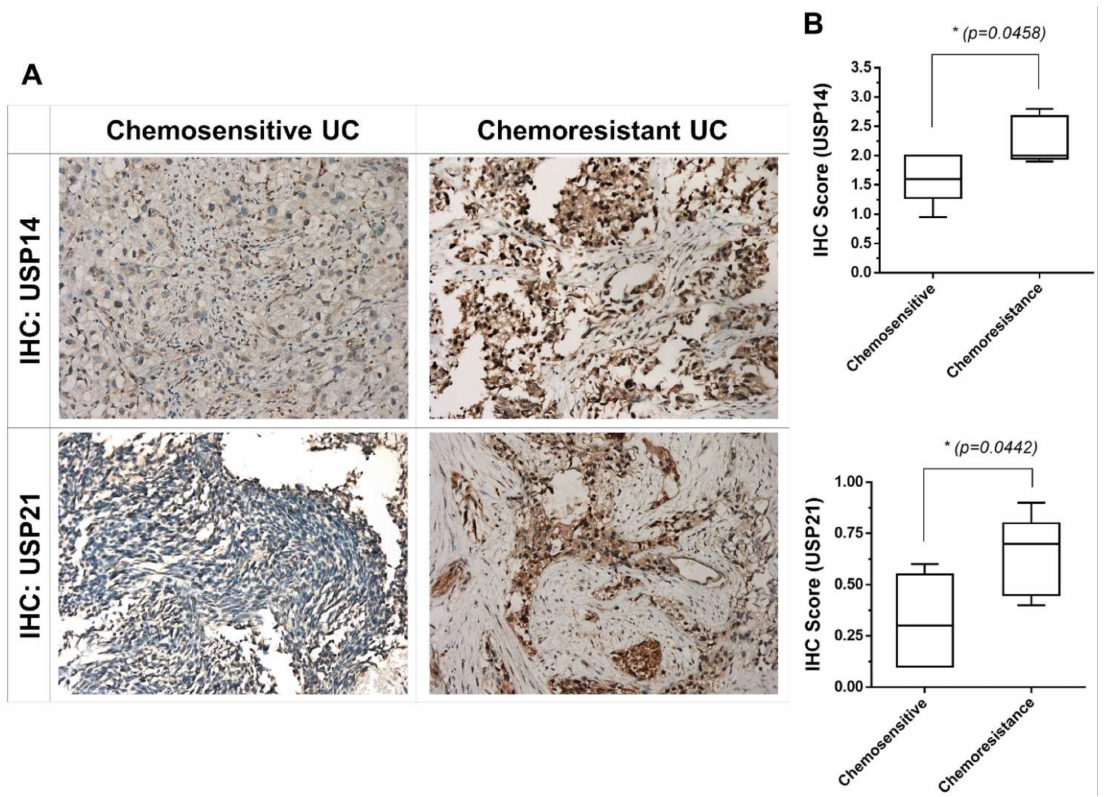
Figure 2. Immunohistochemical staining of USP14 and USP21 in tumor tissues obtained from patients with chemosensitive and chemoresistant metastatic bladder urothelial carcinoma. ( A ) Five chemoresistant and five chemosensitive clinical tumor samples were IHC-stained with USP14 and USP21 antibodies. The tissue sections were photographed at 200 × magnification. ( B ) The IHC scores of USP14 and USP21 expression from chemoresistant and chemosensitive tumors. Data were analyzed using the unpaired two-tailed Student’s t -test and are presented as means ± standard deviation; * p < 0.05 represents a significant difference between the indicated